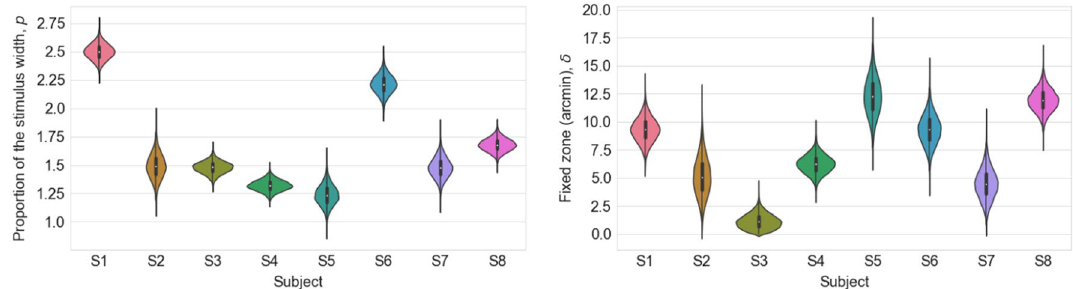
Figure 6. In the model, the parameter estimates for the proportion of stimulus width, p is between 1.25 and 2.5 cycles (left panel). The constant term delta is 5–12.5 arc minutes for most subjects (right panel).